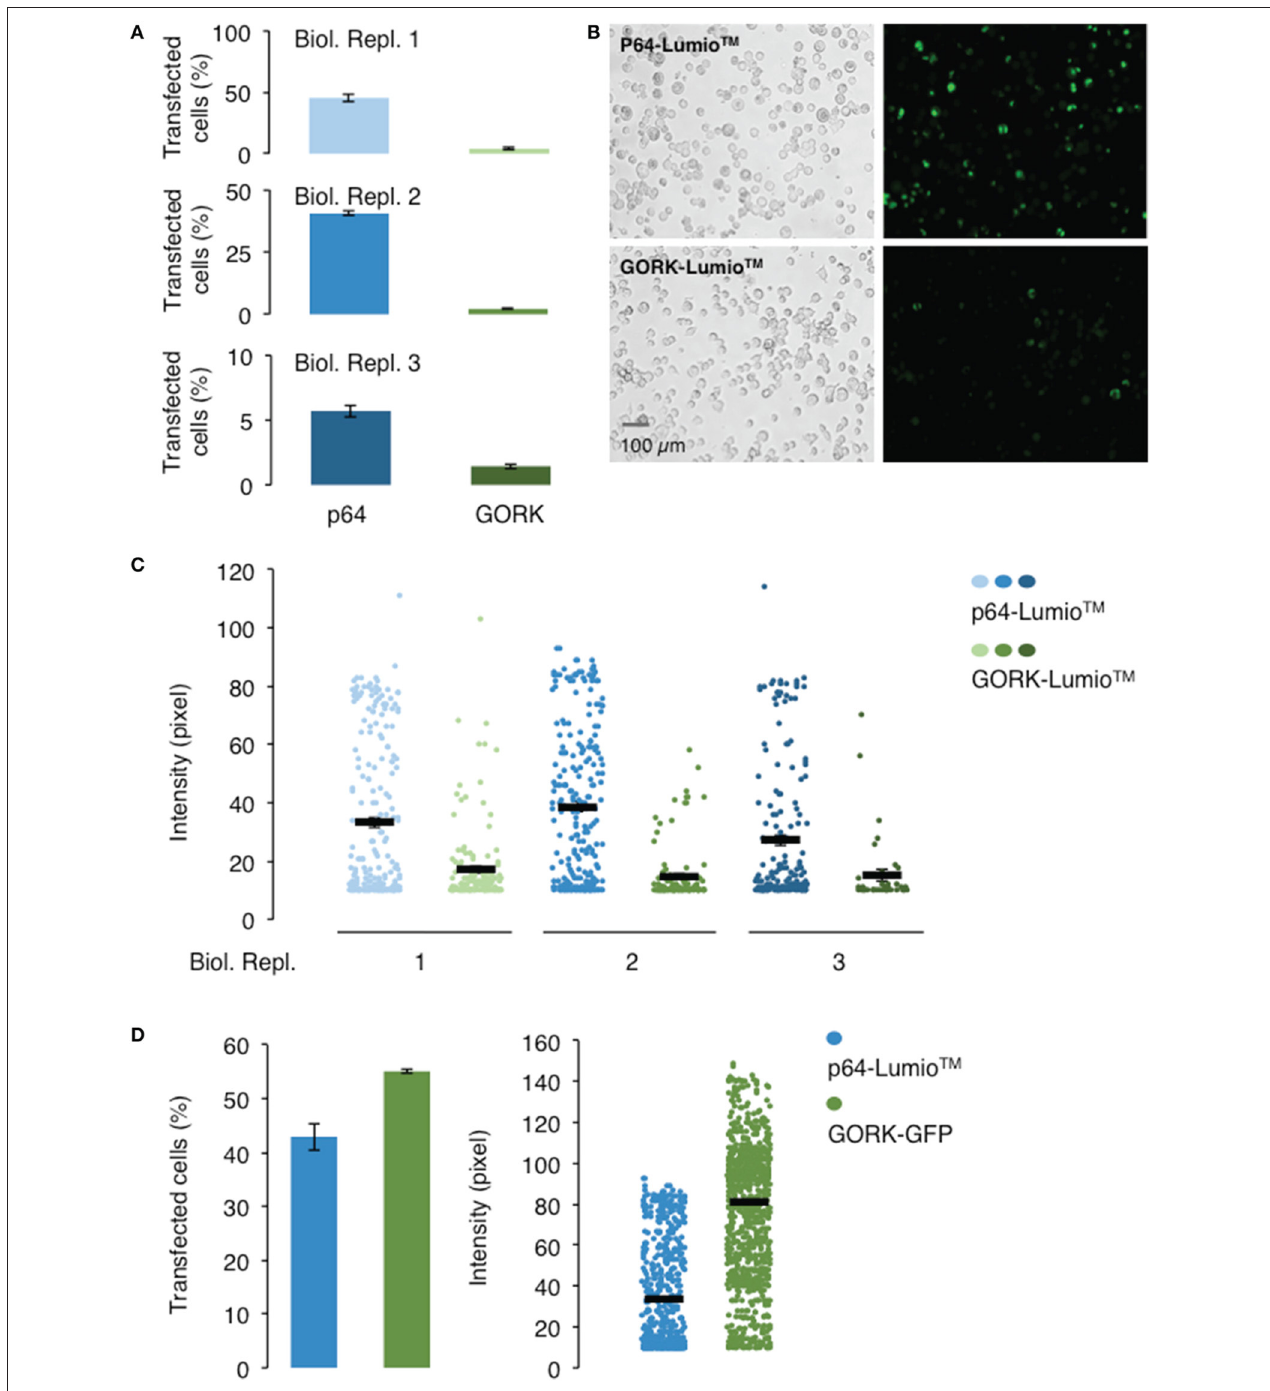
FIGURE 1 | Transfection and expression efficiencies of AtGORK tagged with Lumio TM and AtGORK fused with EmGFP in HEK-293 cells. (A) HEK-293 cells transfected with AtGORK -cLumio TM expression vector has reduced transfection efficiency as compared to the expression of the positive control p64 that is consistent across all three biological replicates. (B) Representative images showing the poor transfection efficiency of cells transfected with AtGORK -cLumio TM and the p64 positive control plasmids. (C) The expression of AtGORK in green fluorescence cells is lower than that of p64 using the Lumio TM system as determined by their pixel intensities. (D) The AtGORK-EmGFP has a higher transfection efficiency and protein expression than that of the nLumio TM -tagged p64 in HEK-293 cells. A typical 20 × magnification of 293FT cell image contains 2560 × 1920 pixels and is converted to an 8-bit byte image based on a scale of 0–255 using ImageJ (Schneider et al., 2012). The lower limit cut-off representing appreciable and above background fluorescence, was set at 10 pixels. Transfection efficiency and protein expression of more than 100 cells in each viewing field were analyzed (see Section Procedure for analysis).